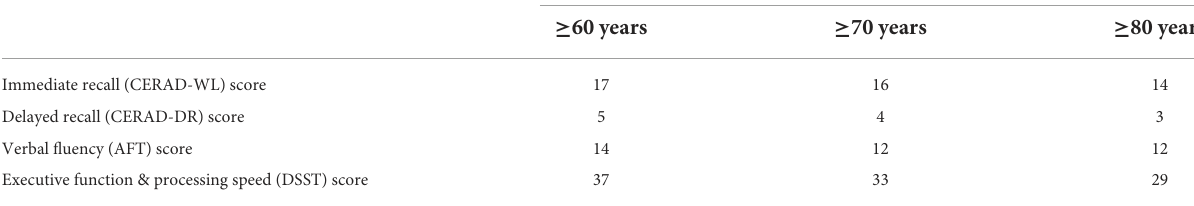
TABLE 1 The cutoff points of cognitive function test scores adjusted by age. Cognitive